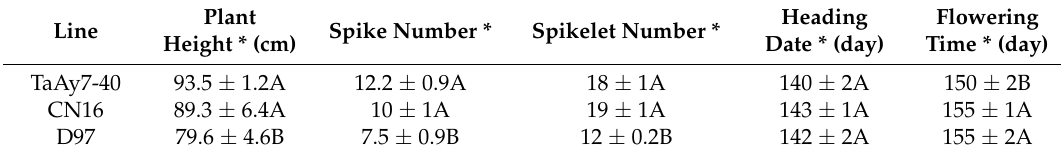
Table 2. Comparison of grain traits between the TaAy7-40 and its parents CN16 and D97.